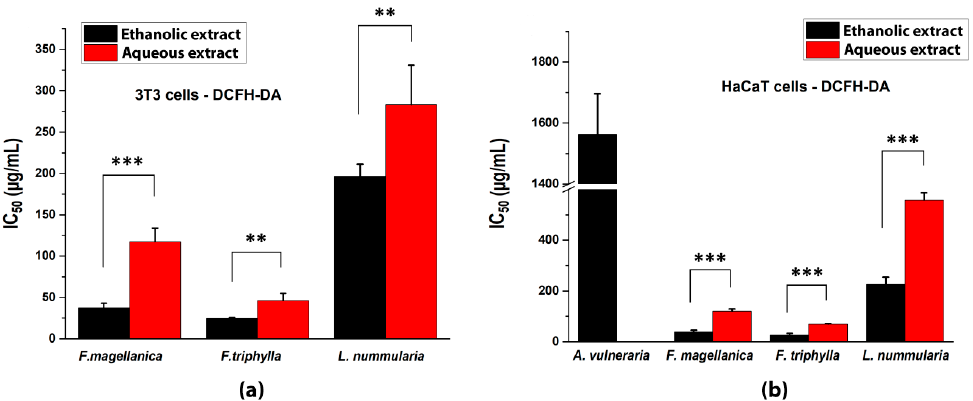
Figure 3. Intracellular antioxidant capacities of studied plant extracts with DCFH-DA staining ( a ) in 3T3 fibroblast cells and ( b ) in HaCaT keratinocyte cells. IC 50 inhibitory concentrations were calculated from the equations obtained for the inhibitory capacities of the serial dilutions of the extracts. In the case of A. vulneraria the DCFH-DA scavenging activity data (when not shown) were at around/below the detection limit. Mean ± SD of five independent experiments, n = 5 × 4 replicates for each